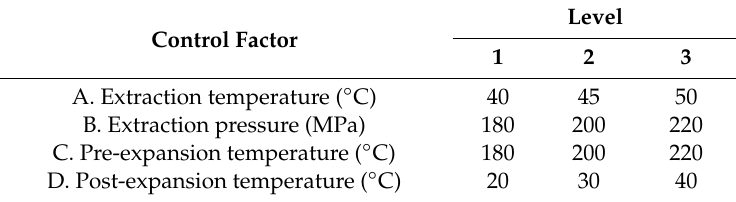
Table 1. The control factors and levels of the Taguchi experiments.